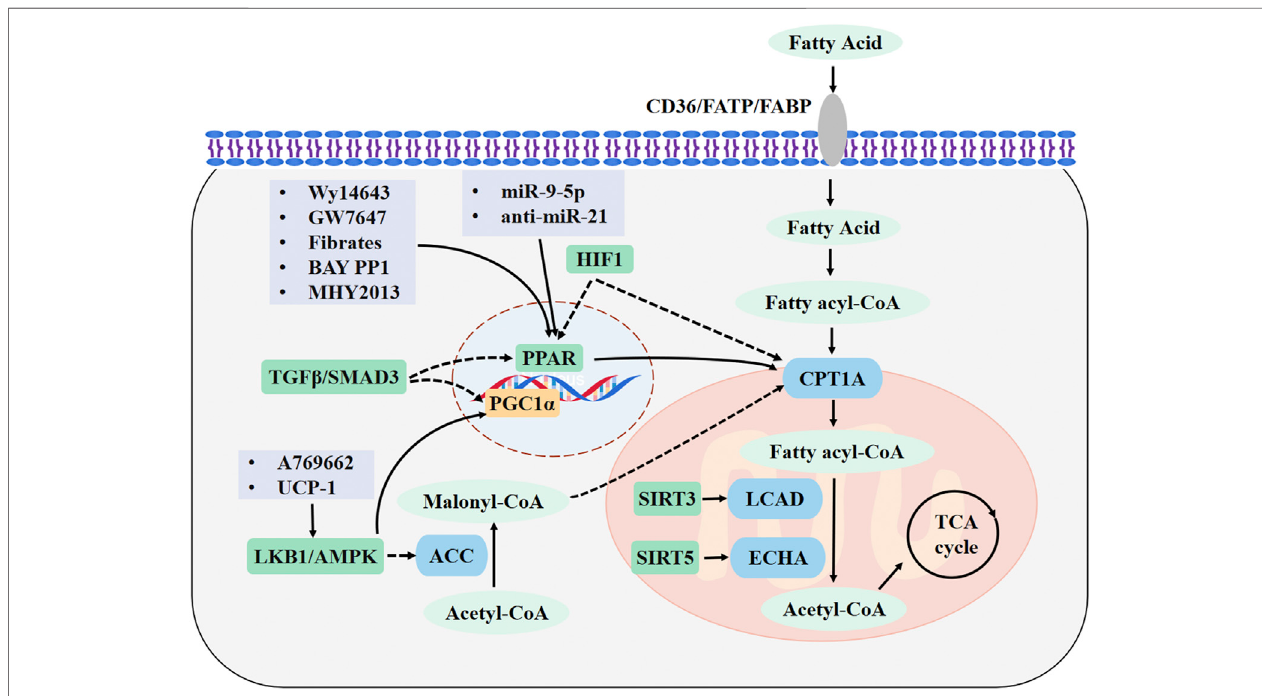
FIGURE 1 | Major FAO pathways involved in kidney diseases and drug targets. Fatty acids (FAs) enter the cytoplasm through CD36, FABPs, or FATPs. In the cytosol,FAsareactivatedtofattyacyl-CoAandtransportedintothemitochondrialmatrixthroughCPT1A.Theacyl-CoAundergoesa β -oxidationreactiontoformacetyl- CoA, which is completely oxidized by the tricarboxylic acid cycle. FAO is promoted by upregulating CPT1A and PPAR signaling. Drugs are highlighted in light purple boxes. Enzymes are shown in blue and metabolites are shown in lightgreen. Regulatory molecules are shown in green boxes. FAO, fatty acid β -oxidation; CPT1A, carnitine palmitoyl transferase 1A; FABP, FA-binding protein; FATPs, FA-transport protein; PPAR, peroxisome proliferators-activated receptor; PGC-1 α , peroxisome proliferator-activated receptor γ coactivator 1 α ; AMPK, adenosine monophosphate-activated protein kinase; LKB1, Liver kinase B1; ACC, acetyl-CoA carboxylase; LCAD, long-chain acyl-CoA dehydrogenase; ECHA, enoyl-CoA hydratase; SIRT3, sirtuin 3; SIRT5, sirtuin